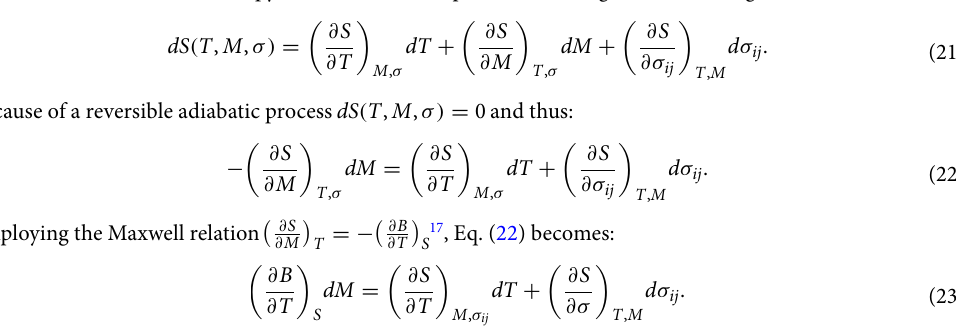
x is applied. Figure based −